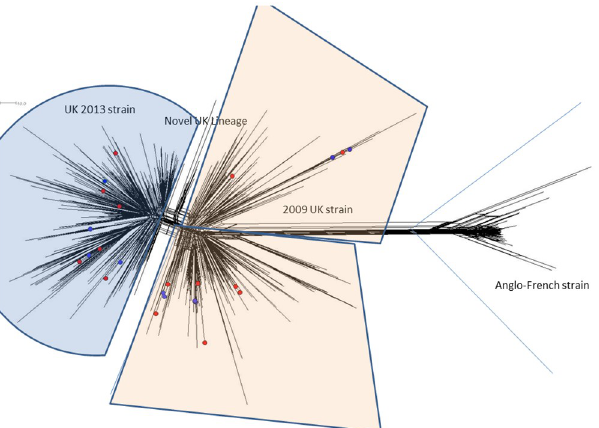
Fig 5. cgMLST NeighbourNet diagram of Irish MenW:cc11 isolates and representative examples of European MenW:cc11 isolates (unlabelled). Unlabelled isolates were chosen and represent the cc11 lineage structure established in 2015 (Lucidarme et al ), and included examples of the original Hajj strain (Anglo-French strain), and the more recent UK 2009, and novel UK 2013 strains. Irish disease associated cases (n = 16, 2010–2017) are highlighted in red, and nasopharyngeal carriage isolates (n = 12, 2016/17) are highlighted in blue, and are observed interspersed among both the UK 2009 and novel 2013 UK strain clusters. There were no examples among the Irish study isolates of the original Hajj strain. Scale bar represents a pairwise allelic difference of